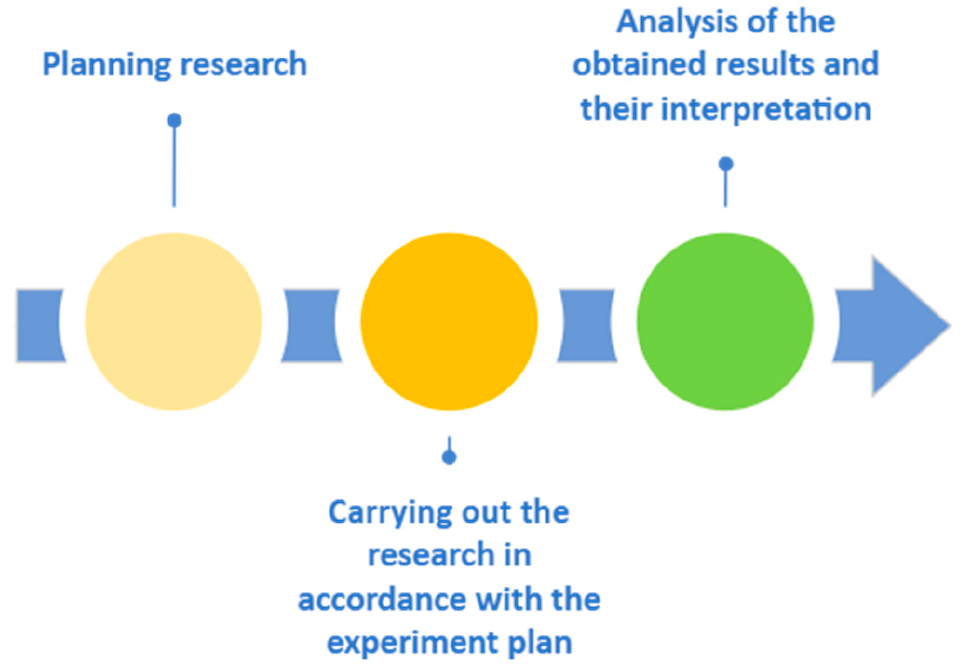
Figure 1. The research schedule for performing the research.